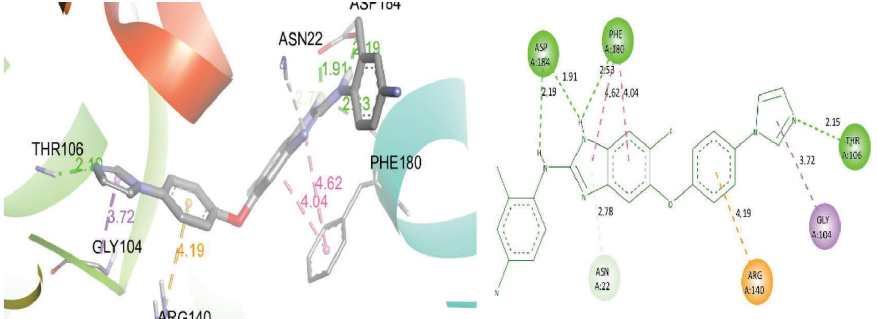
Figure 6: 3D and 2D interaction of A19 with FtsZ protein.